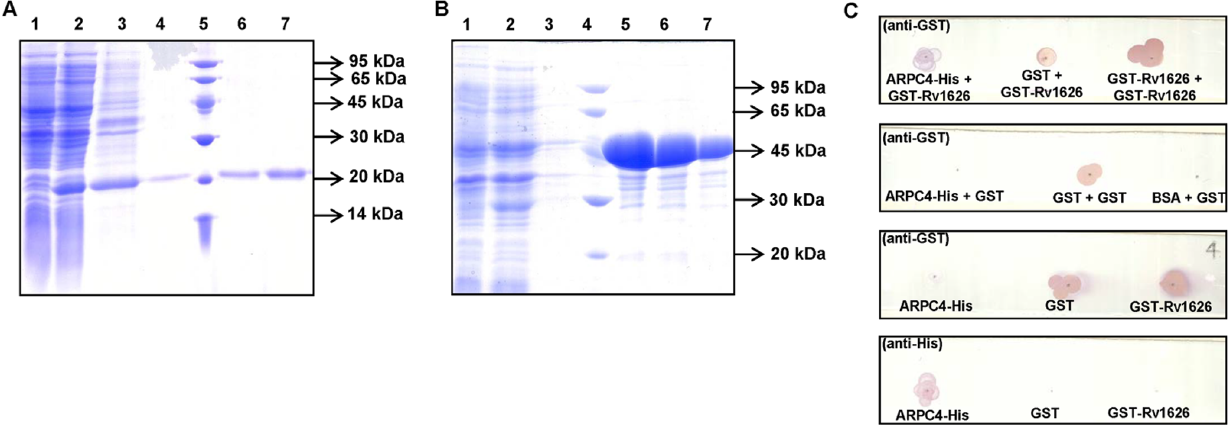
Figure 5. Rv1626-ARPC4 protein-protein interaction invitro . A. Coomassie-stained purification gel of ARPC4-His 6X . ARPC4-His 6X protein was purified under denaturing conditions on a Ni-NTA column. 15% SDS polyacrylamide gel showing purified C-terminal His-tagged ARPC4 protein, stained with coomassie blue. Lane 1: uninduced cell lysate, Lane 2: induced cell lysate, Lane 3: supernatant fraction of cell lysate (load), Lane 4: final wash, Lane 5: low molecular weight protein marker (the sizes, in kDa, are indicated on the left of the panel), Lane 6–7: purified protein elution fractions. B. Coomassie-stained purification gel of GST-Rv1626 proteins GST-Rv1626 protein was purified under native conditions on a Glutathione Sepharose-4B resin column. 15% SDS polyacrylamide gel showing the purified GST-Rv1626 protein, stained with coomassie blue. Lane 1: uninduced cell lysate, Lane 2: induced cell lysate, Lane 3–7 (except 4) are fractions collected from the column; Lane 3: wash fraction, Lane 4: low molecular weight protein marker (the sizes, in kDa, are indicated on the left of the panel), Lane 5–7: purified protein elution fractions. C. Dot Far-Western Blots showing in vitro protein-protein interactions. 1 m g each of purified ARPC4-His 6X , GST, GST-Rv1626 or BSA proteins were immobilized on nitrocellulose strips that were incubated overnight in 1 m g/mL solution of the either GST-Rv1626 or GST protein. The strips were then developed using the antibody indicated in the parenthesis.